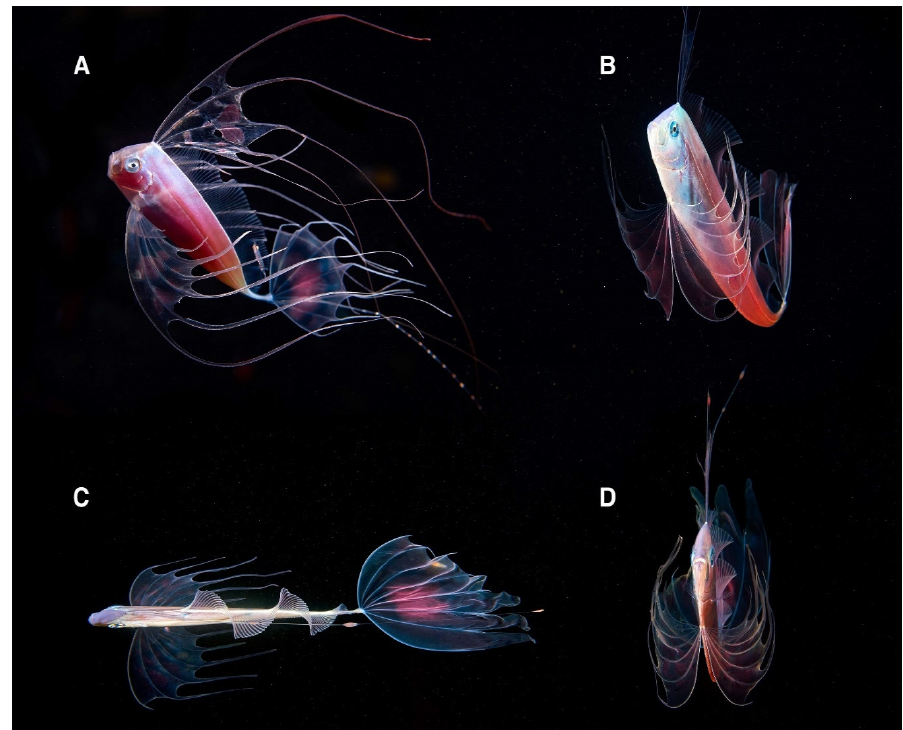
Figure 5. Lateral ( A) , fronto-lateral ( B ), dorsal ( C ), and frontal ( D ) view of juvenile specimens of T. trachypterus, with detail of fins orientation accordingly to the observer visual axis.